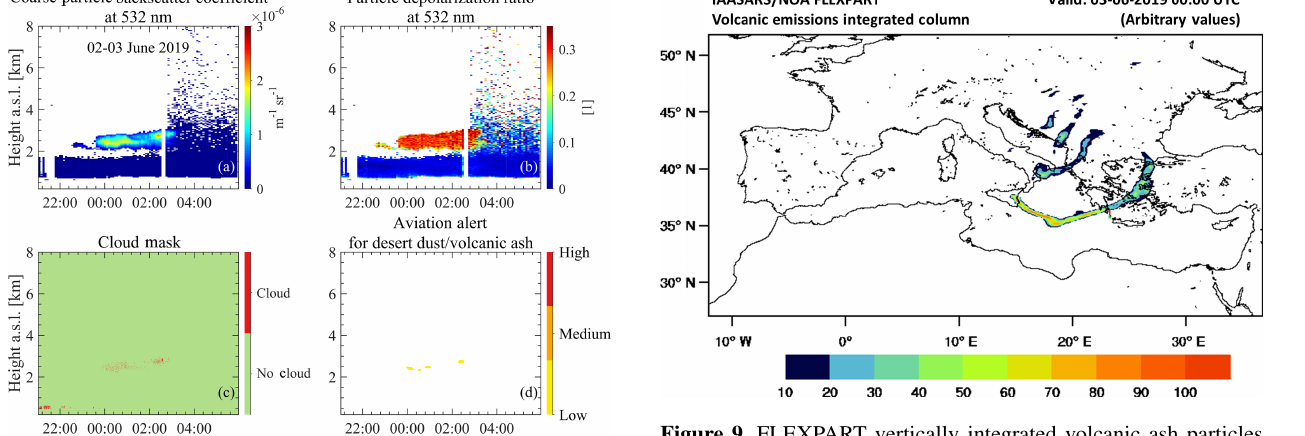
Figure 9. FLEXPART vertically integrated volcanic ash particles (arbitrary values) originating from Mount Etna on 3 June 2019 at 00:00UTC. The green star indicates the location of Antikythera, and the red line is the misplacement of the simulated plume from the lidar